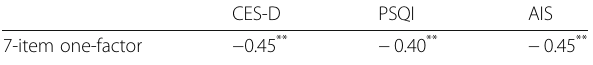
Fig. 2 Standardized coefficients of the seven-item Chinese version of Toronto Hospital Alertness Test (THAT)